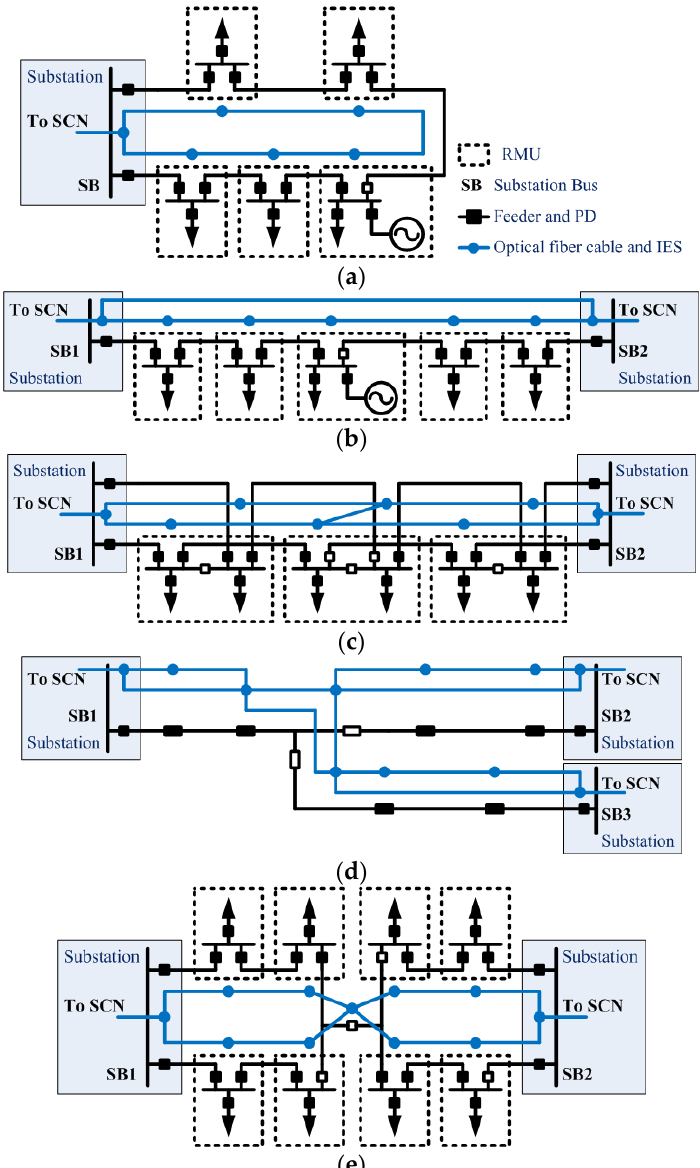
Figure 2. The topology of the communication system for ( a ) open loop connection from same substation, ( b ) open loop connection from different substations, ( c ) double shunt connection, ( d ) overhead line with multiple sources, and ( e ) lattice type loop connection.